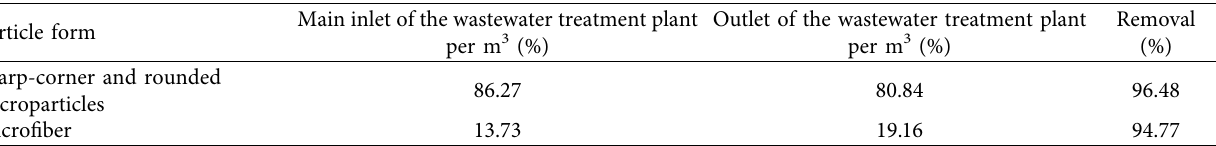
Table 6: Abundance of diferent types of microplastics existing in the inlet and outlet streams of the wastewater treatment plant and the removal efciency (for example in summer).